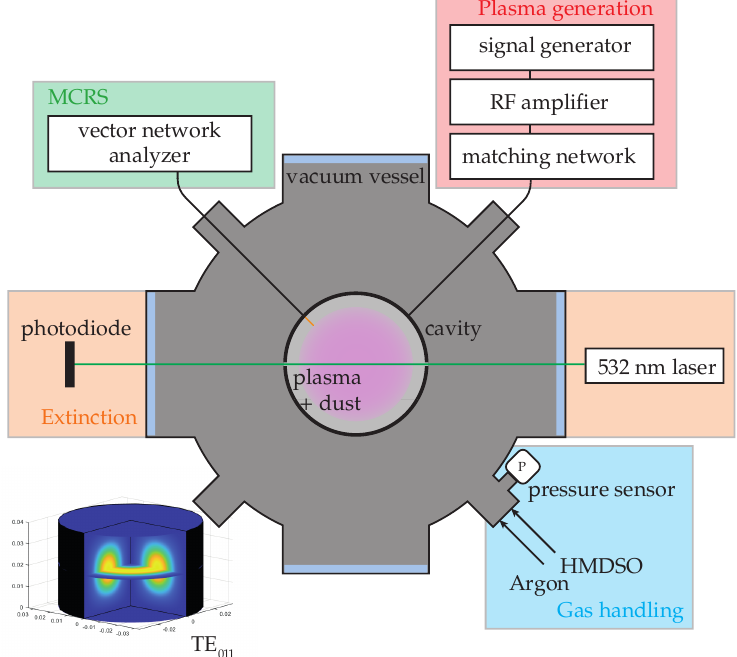
TE 011 Figure 1. Schematic top view of the experimental setup for monitoring dust particle growth in a low-pressure Ar-HMDSO plasma. The plasma was generated in a cylindrical cavity inside a vacuum vessel. The free electron density of the plasma was measured using a vector network analyzer. The TE 011 mode was used for the MCRS measurements, of which the mode pattern is shown in the inset. Simultaneously, a green laser ( λ = 532nm) was used to perform laser light extinction measurements on the dust